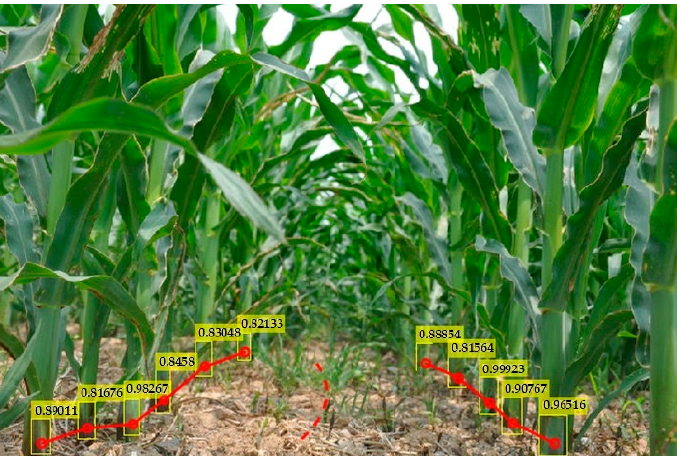
Figure 10. Schematic diagram of line of proposed cooperation.